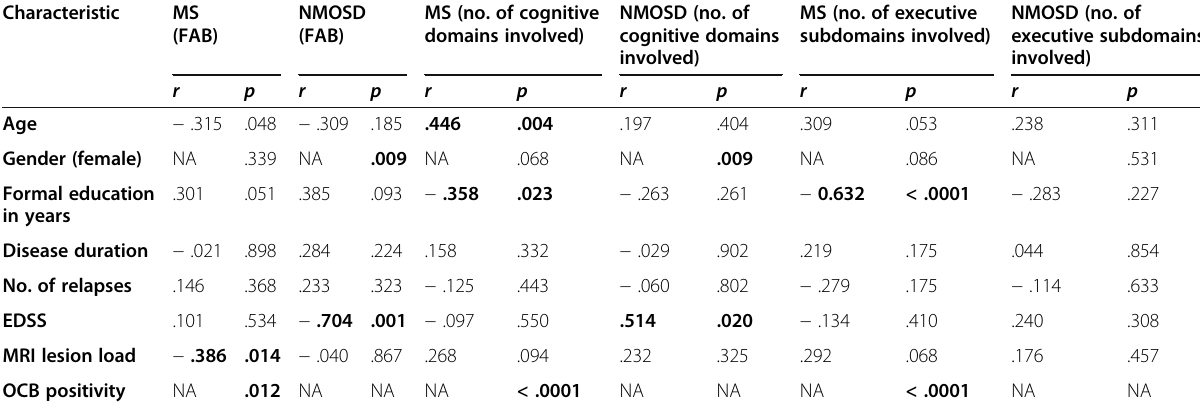
Table 5 Association between demographic, clinical, and MRI characteristics and cognitive dysfunction in MS and NMOSD patients Characteristic MS NMOSD MS (no. of cognitive NMOSD (no. of MS (no. of executive (FAB) (FAB) domains involved) cognitive domains subdomains involved) involved)